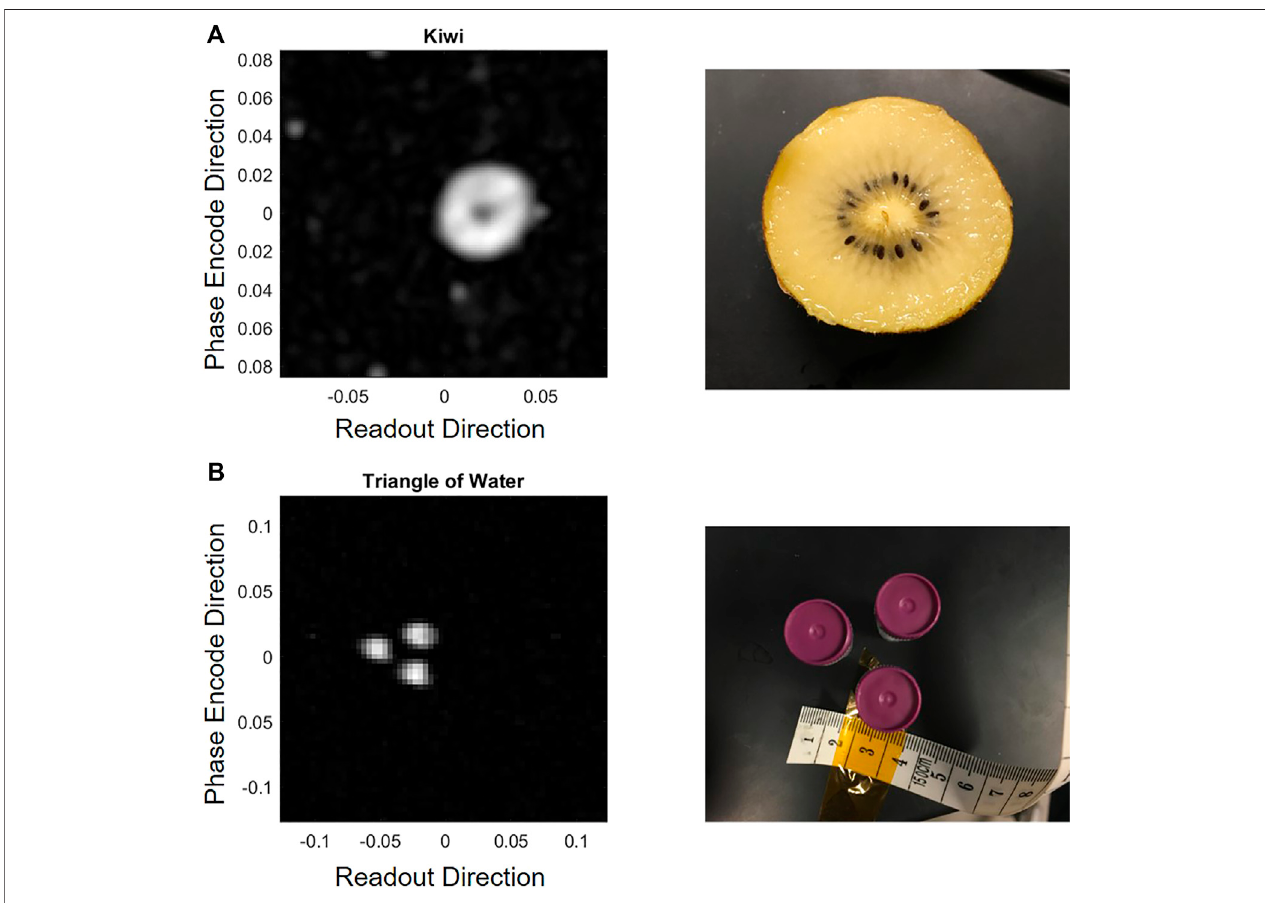
FIGURE 8 | Images of a kiwi (A) and three small bottles of water arranged in a triangle (B) .